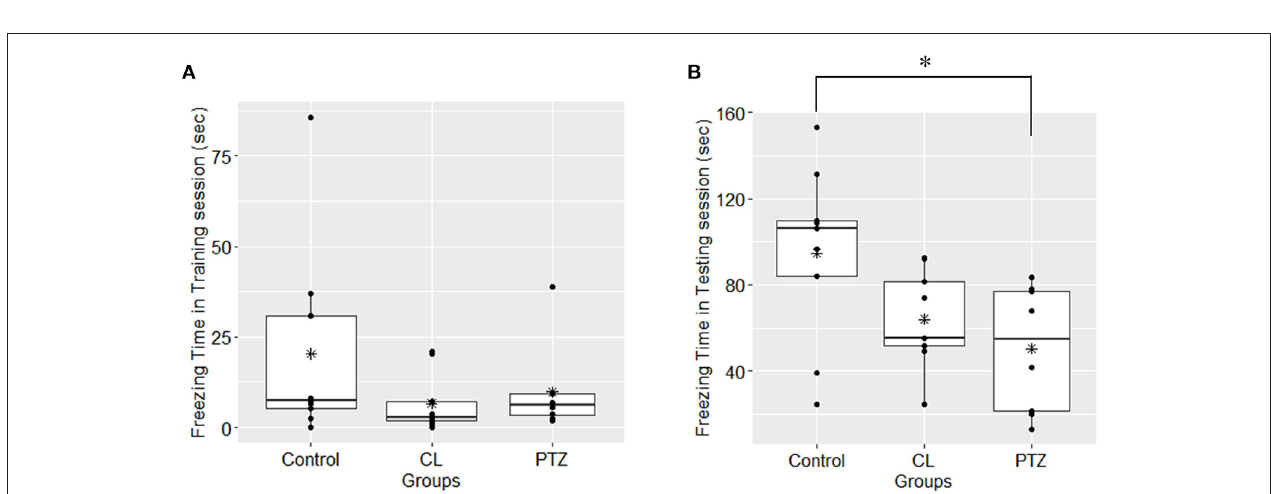
FIGURE 4 | Freezing time (s) in contextual fear conditioning in the three groups. (A) In the first-day training session, no significant difference was found among groups upon the freezing time; (B); in the second-day testing session, the PTZ group demonstrated less freezing time. * P < 0.05.